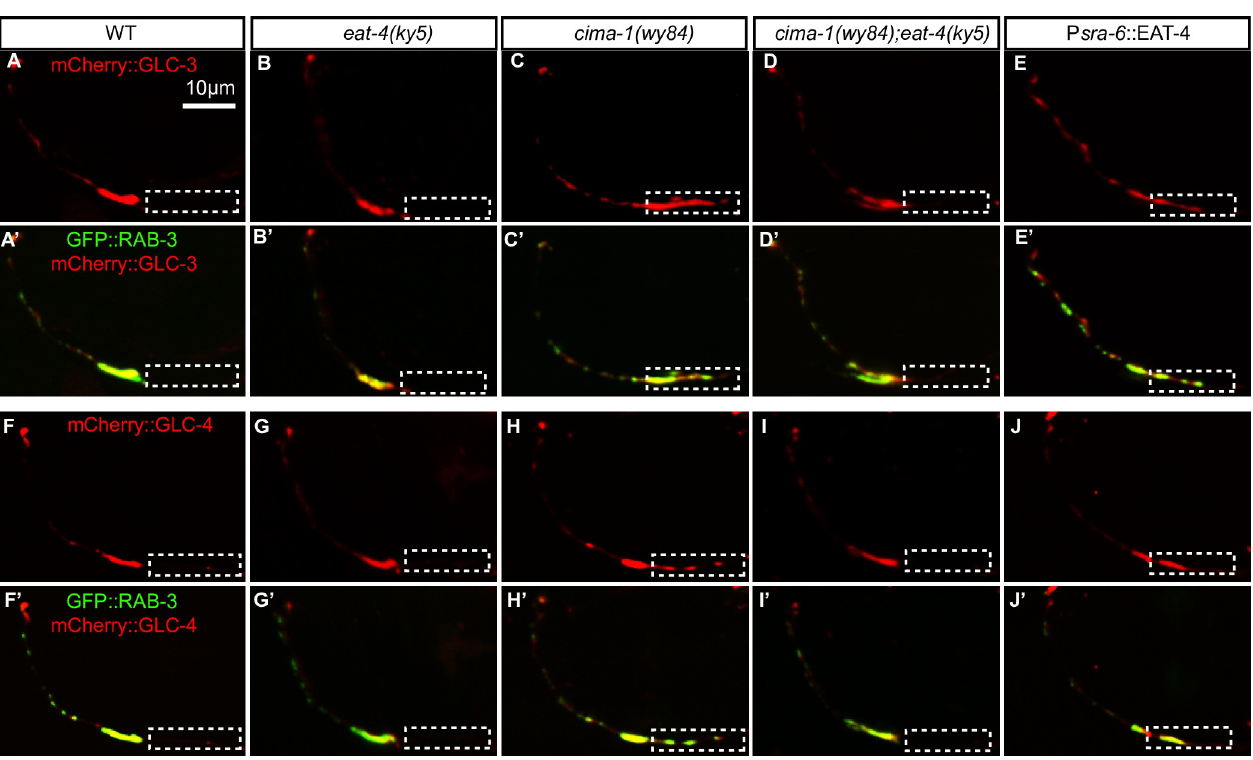
Fig 5. GLC-3 and GLC-4 are enriched at the synaptic region in AIY interneurons. (A-E’) Representative confocal micrographs of mCherry::GLC-3 and GFP::RAB-3 double labeling in AIY interneurons. The mCherry::GLC-3 (A-E) and GFP::RAB-3 are partially colocalized in wild type (A’), eat-4(ky5) (B’), cima-1(wy84) (C’), cima-1(wy84);eat-4(ky5) (D’) and the ASH-specific eat-4 overexpressed animals (E’). (F-J’) Representative confocal micrographs of mCherry::GLC-4 and GFP::RAB-3 double labeling in AIY interneurons. The mCherry::GLC-4 (F-J) and GFP::RAB-3 are partially colocalized in wild type (F’), eat-4(ky5) (G’), cima-1(wy84) (H’), cima-1(wy84);eat-4(ky5) (I’) and the ASH-specific eat-4 overexpressed animals (J’). GLC-3 and GLC-4 are ectopically localized to the zone 1 in cima-1(wy84) or ASH-specific eat-4 overexpressing animals. Scale bar in (A) is 10 μ m and applies to all images in Fig 5.